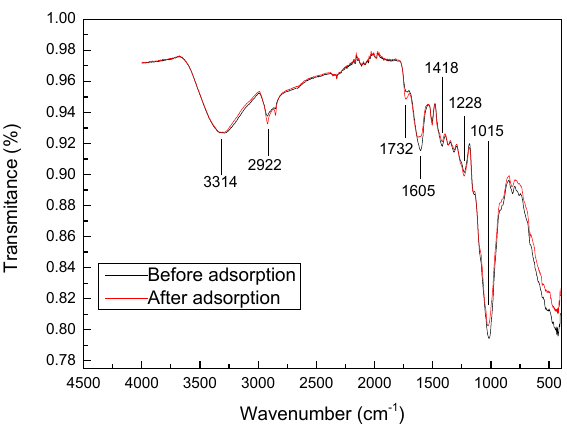
Figure 12: FT-IR spectra of the fermented Magnolia officinalis residues before and after the adsorption of Cu 2+